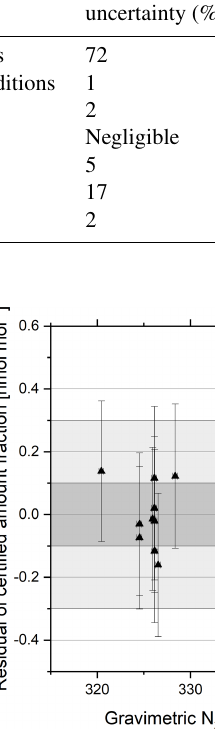
Table 1. Sources of uncertainty and their relative contribution to the combined expanded uncertainty ( k = 2) for the preparation of a 325nmolmol − 1 N 2 O-in-synthetic-air reference material. Source of uncertainty Contribution to the gravimetric expanded uncertainty (%) Mass of N 2 O: indirect transfer vessel additions 72